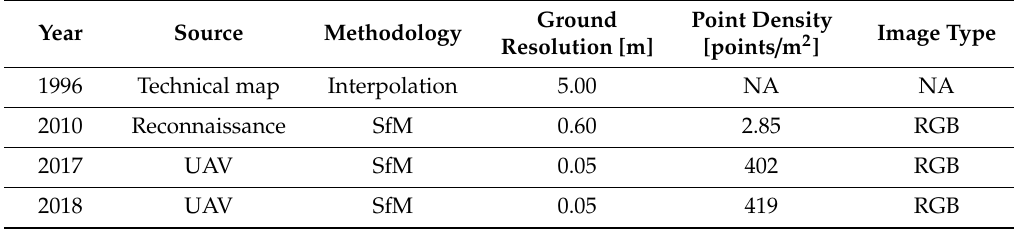
Table 2. DTM technical